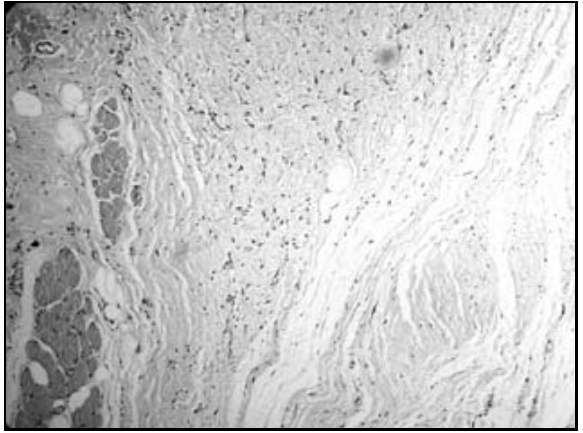
Figura 3 – Área de infiltração em partes moles adjacente a neoplasia (HE 200x)